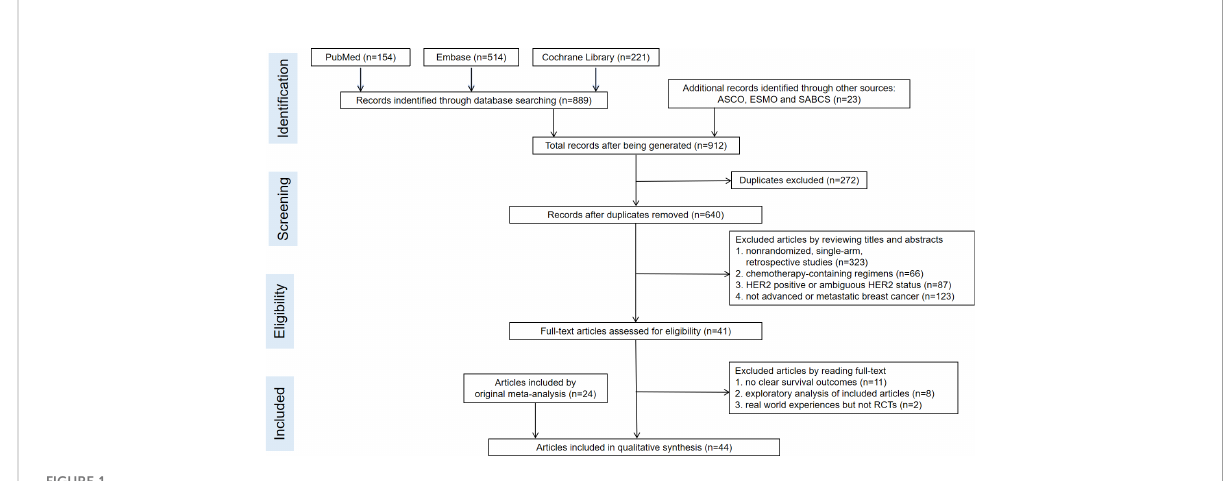
FIGURE 1 The fl ow chart of detailed literature screening process.